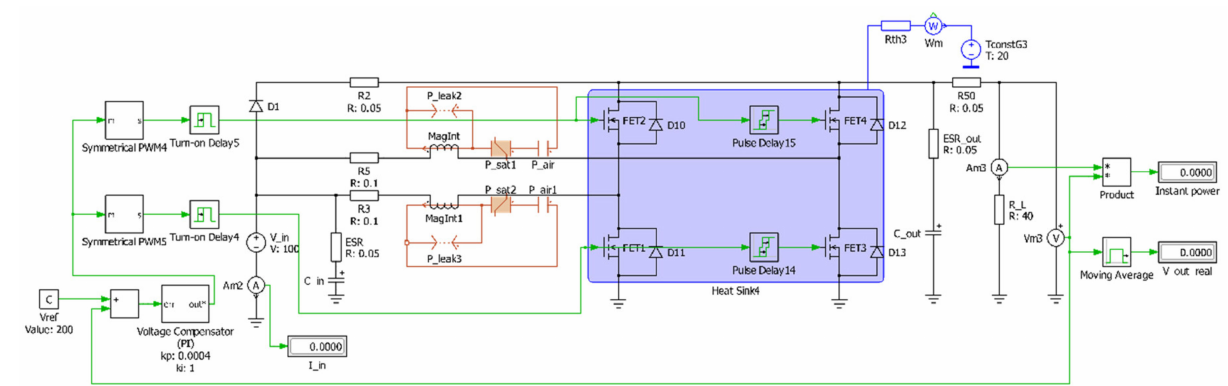
Figure 11. Circuit schematic of the non-modular interleaved Bi-BB converter.